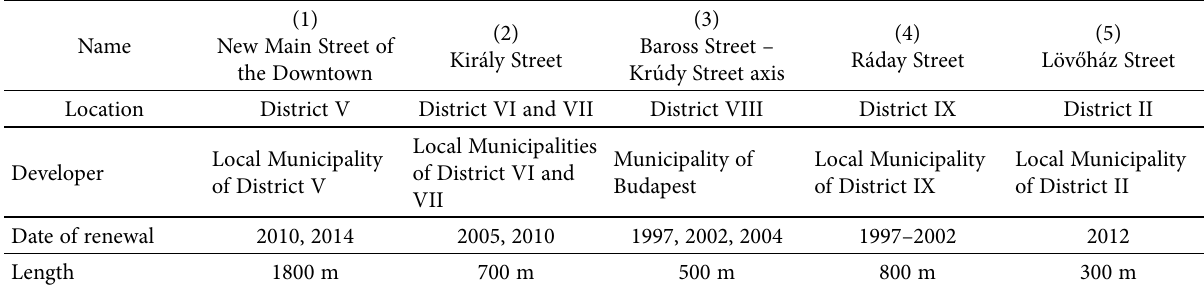
Table 2. General data of the studied areas